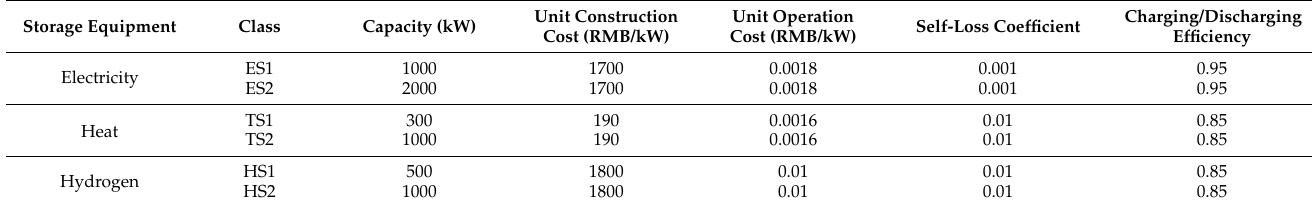
Table 2. Parameters of candidate storage equipment in DES 0.